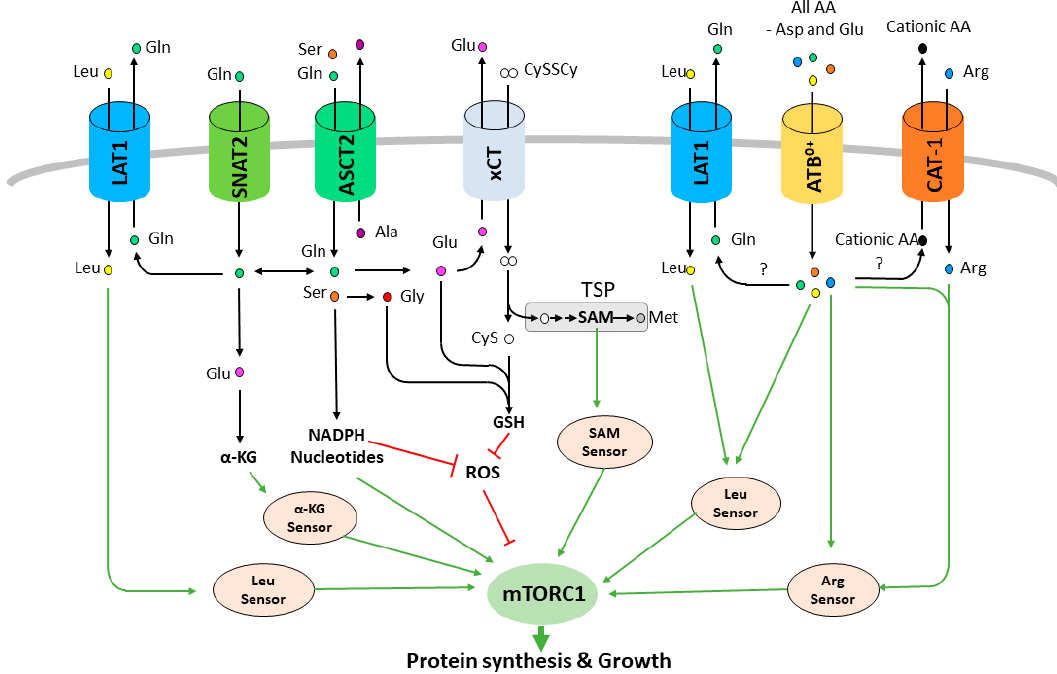
Figure 2. Amino acid transporters regulate mTORC1 activity. Amino acid transporters promote the uptake of leucine, arginine, glutamine, serine, cystine (CySSCy) and other amino acids. These amino acids are sensed directly to activate mTORC1 or converted to downstream metabolites that will activate mTORC1 or inhibit the production of reactive oxygen species (ROS). α -KG: α -ketoglutarate, SAM: S-adenosylmethionine, TSP: Transsulfuration pathway.